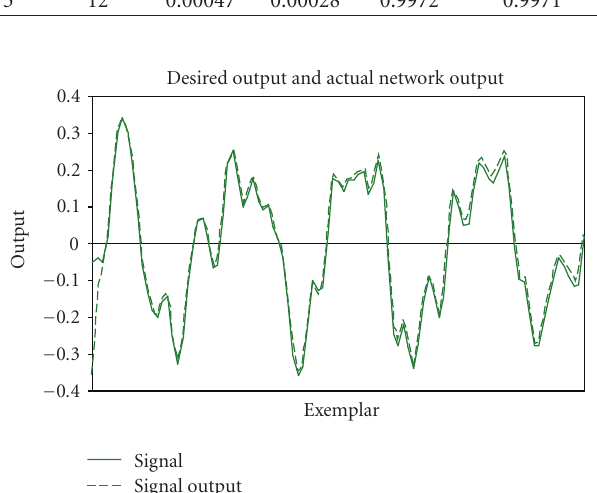
Figure 10: Modeling capability of FTLRNN on training dataset.